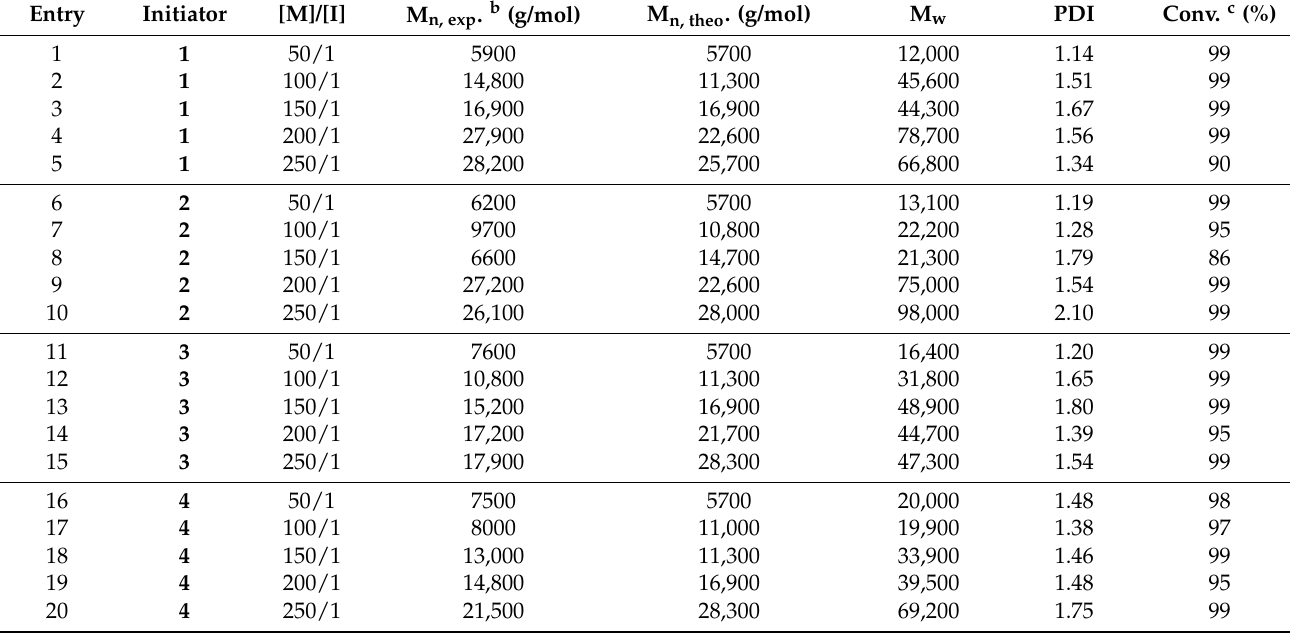
Table 2. Ring-opening polymerization of ε -CL using compounds 1 – 4 as initiator a